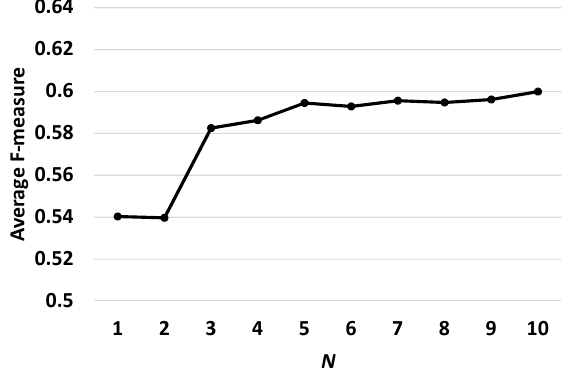
Fig. 4. Facial expression recognition accuracy for each value of N